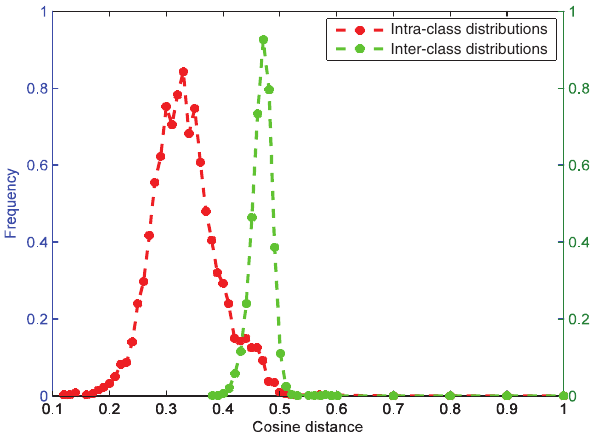
Figure 21. Distribution of Intra-class and Inter-class Cosine Distances Using the CASIAV3 Data Set.